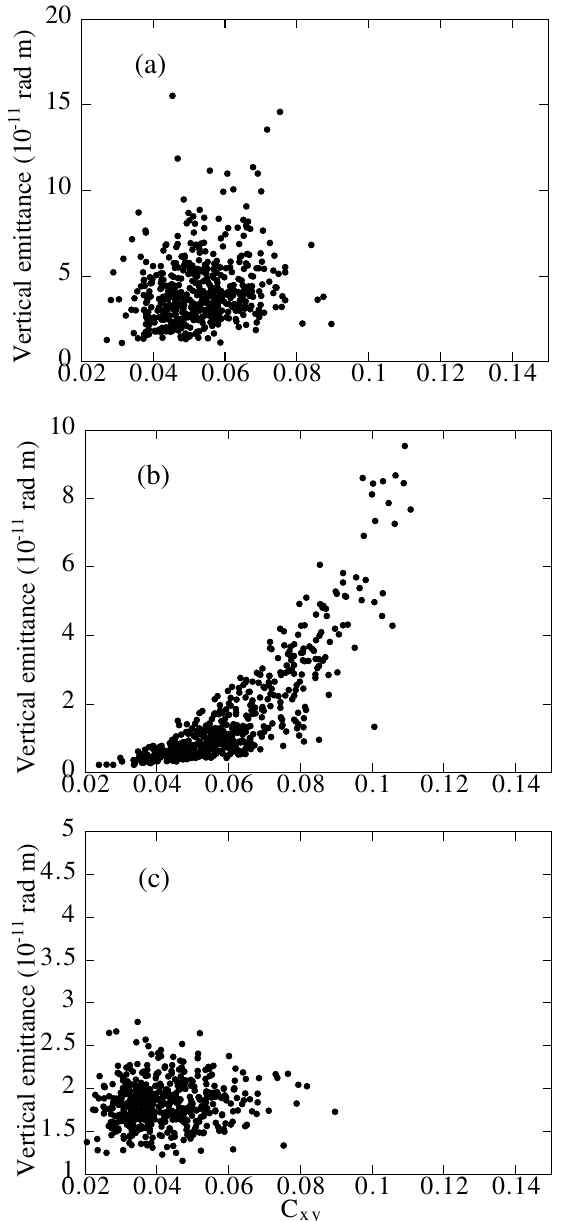
FIG. 7. (cid:26) vs C (a) after COD correction, (b) after COD- y xy dispersion correction, and (c) after coupling